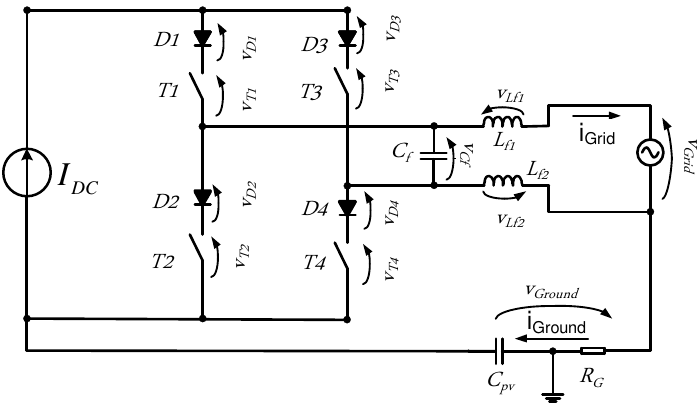
Figure 1. Basic single-phase CSI